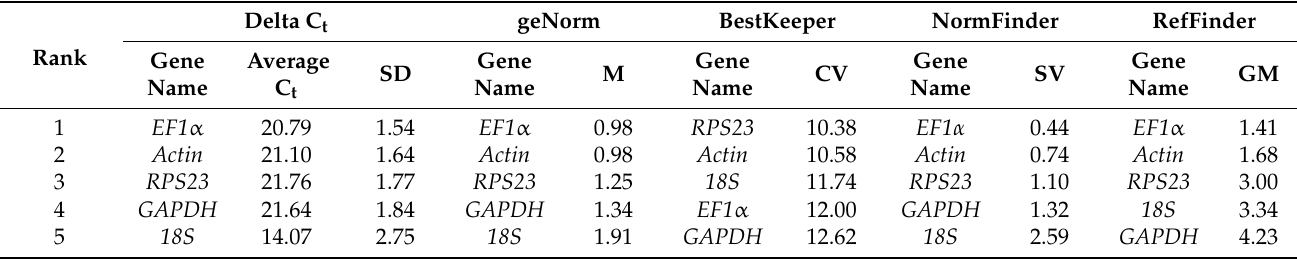
Table 2. Expression variation and stability ranking of the candidate reference genes using geNorm, BestKeeper, NormFinder, and the comprehensive RefFinder algorithm in P. americana .